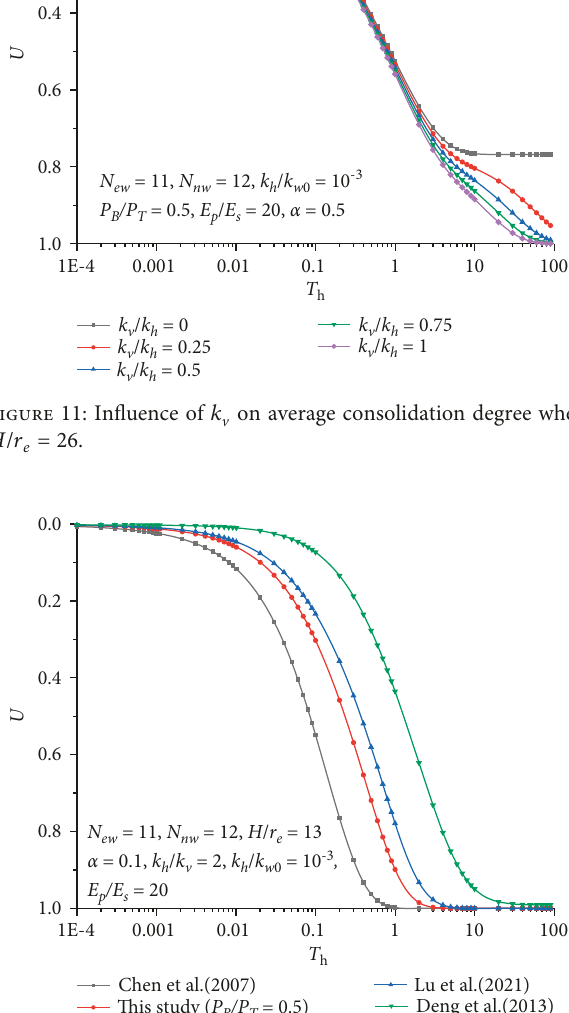
Figure 12: Comparison of the solution in this study with the existing